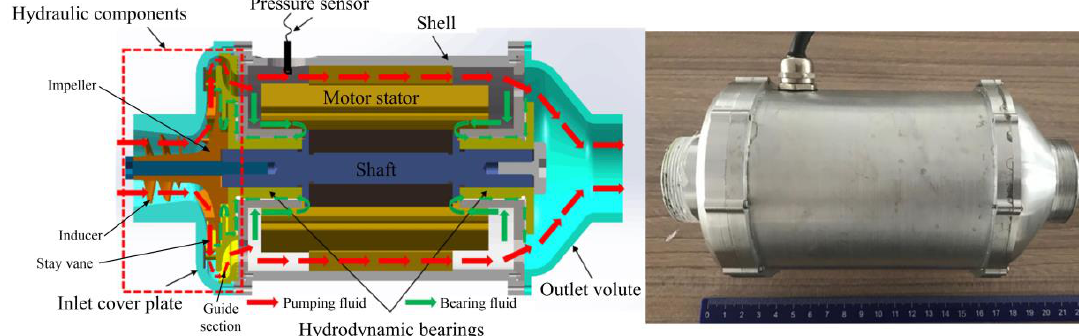
Figure 1. Structure of the novel high-speed centrifugal pump.